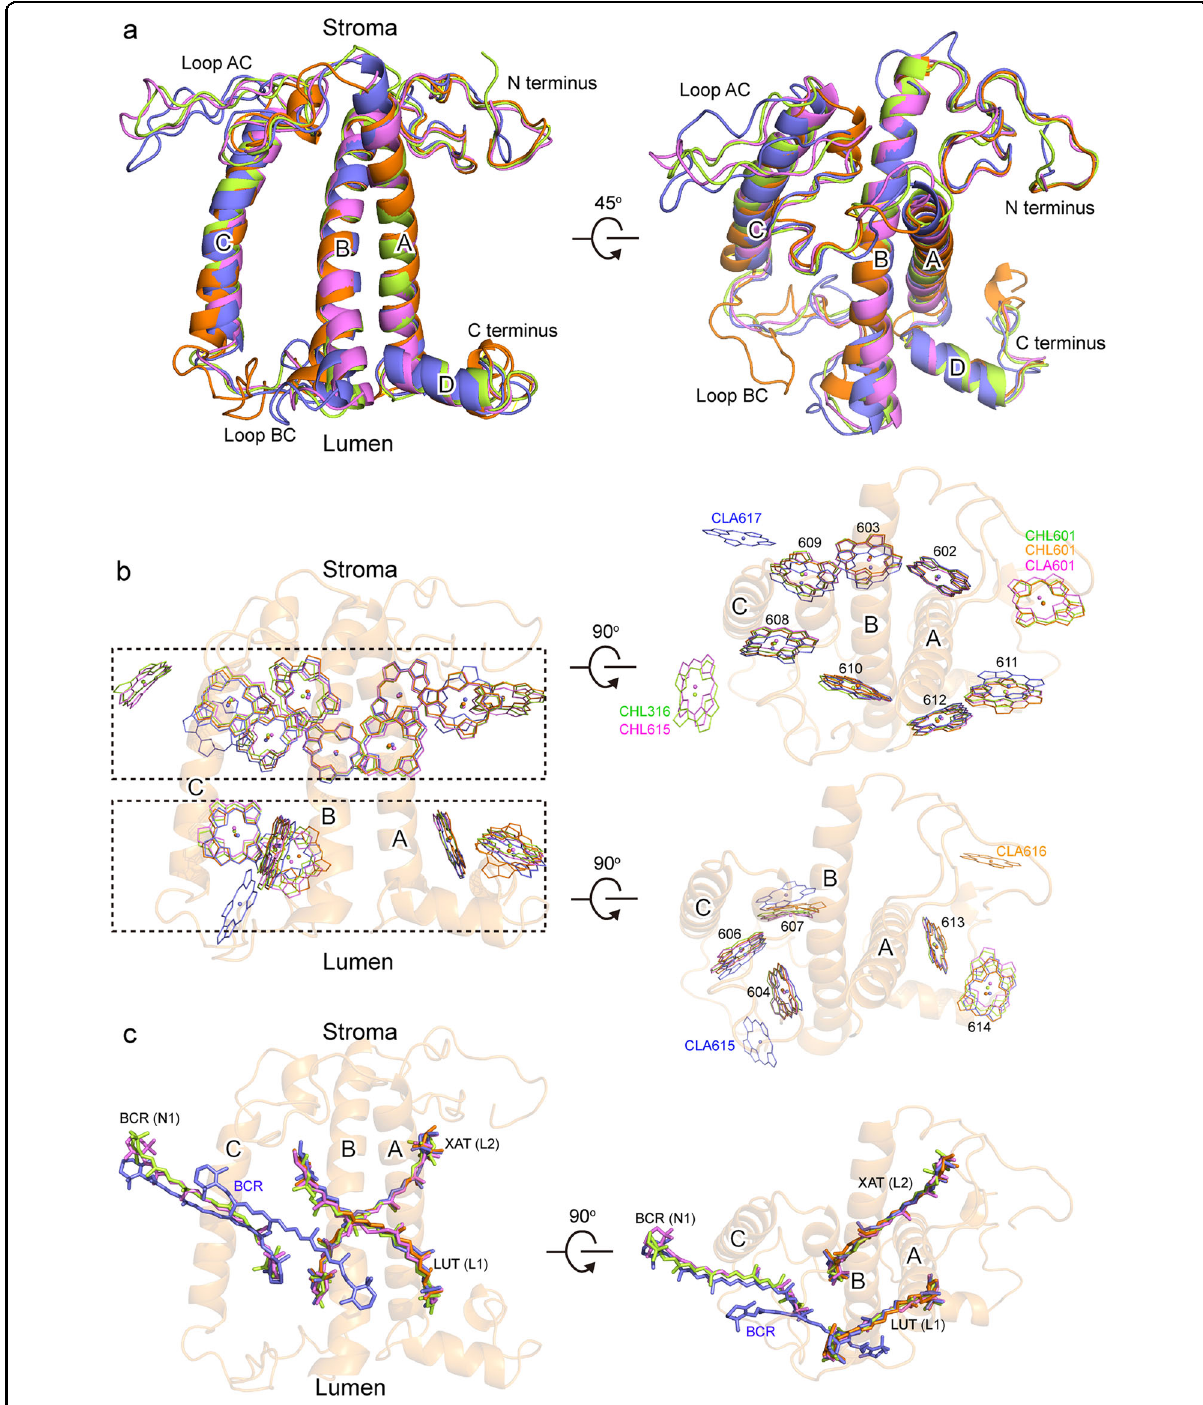
Fig. 3 Comparison of the structures of the four Lhca subunits. a Superposition of the four Lhca apoprotein structures. b Superposition of Chl molecules from the four Lhca subunits, with the structure of the Lhca1 apoprotein shown in transparent orange in panels b and c . c Superposition of Car molecules from the four Lhca subunits. The color codes for the four Lhca subunits are the same as in Fig. 1, and those of pigments are the same as the Lhca subunits they are associated with. Special Chls mentioned in the text are